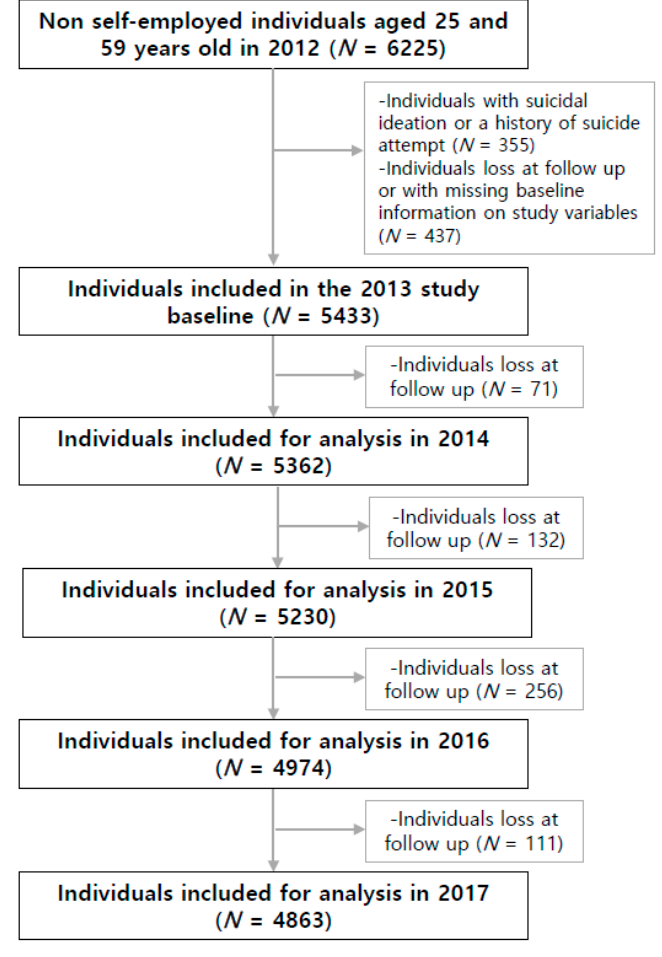
Figure 1. Study Figure 1. Study profile.